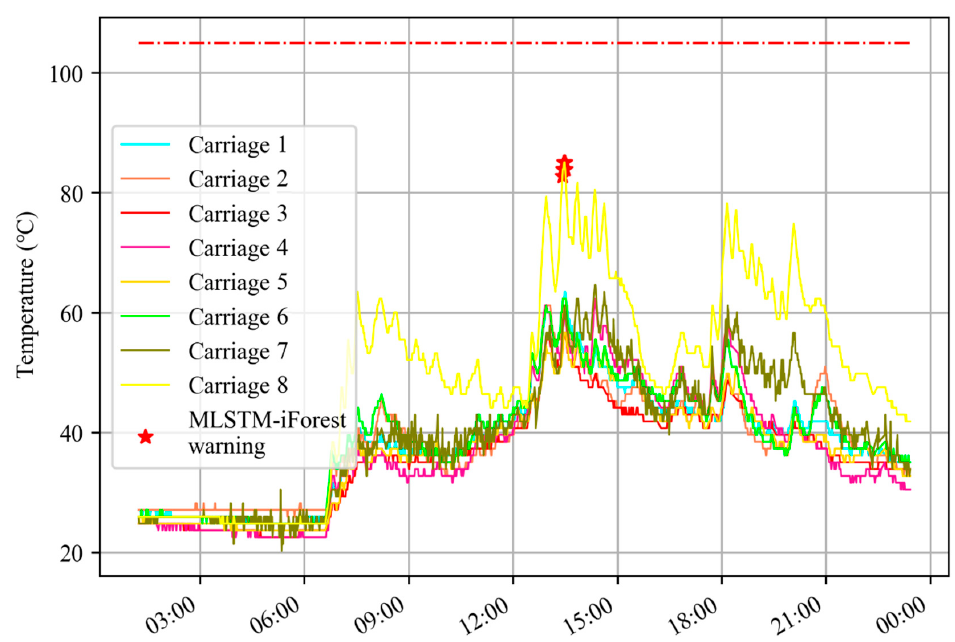
Figure 12. MLSTM-iForest warned two days ahead of EMU-ODS.